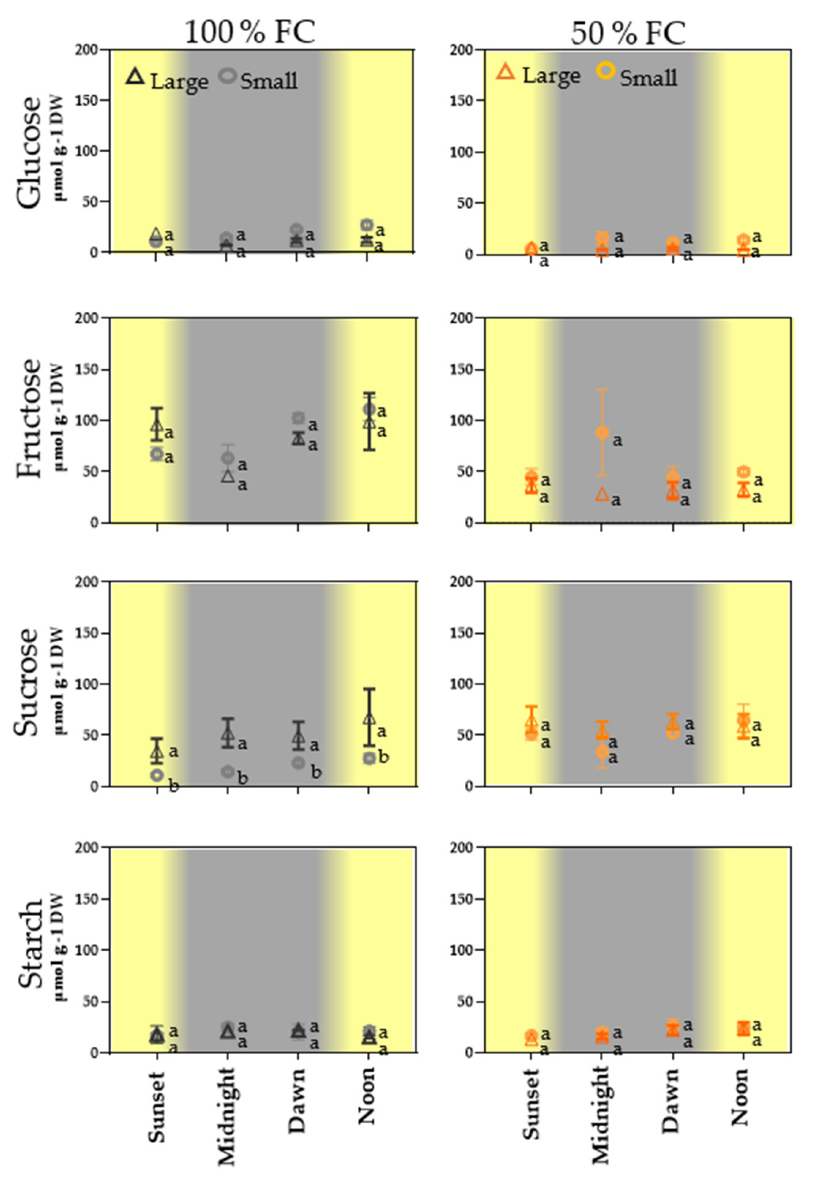
Figure 3. Concentrations ± SE of glucose, fructose, sucrose, and starch in pericarps of large (triangle) and small (circle) pods of racemes of common bean plants at 100% field capacity (FC) over 10 days. Racemes were sampled at sunset (6:00 p.m.), midnight (12:00 p.m.), sunrise (6:00 a.m.), and noon (12:00 p.m.), n = 4. The same letters on the boxes indicate similarity between treatments (Student’s t test, p < 0.05).